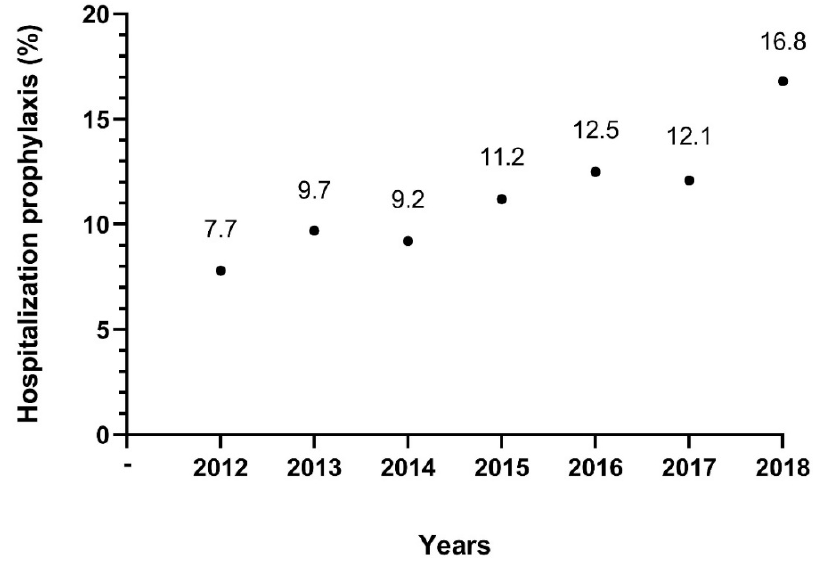
Figure 2. VTE prophylaxis rates of hospitalized patients with IBD between 2012 and